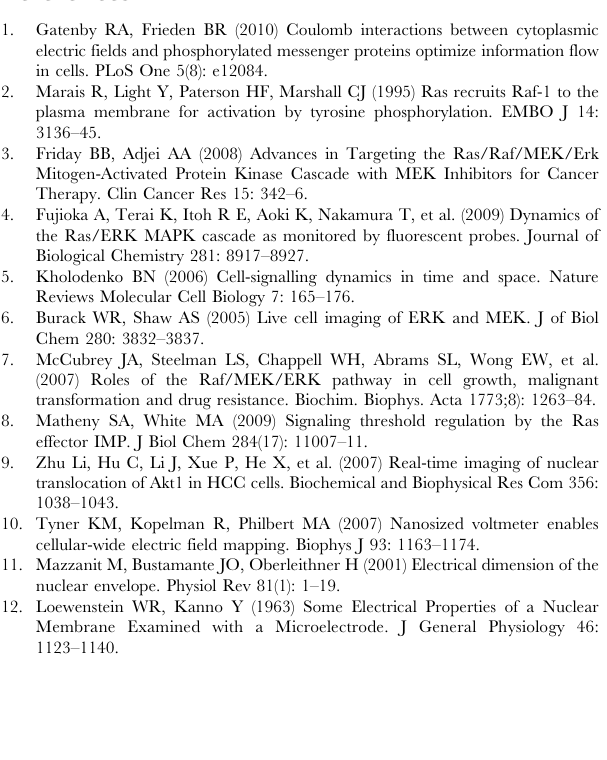
Figure S1 The deviation of the simulation RMS from the theoretical RMS at large h t values is due to the fact that the particles are confined to the inside of the cell wall. This will cause the RMS to plateau instead of increasing along with the theoretical. Figure S2 Speciation diagram of a particle with an isoelectric point of 6.5. These speciation are used to determine the charge of a particle at any given environmental